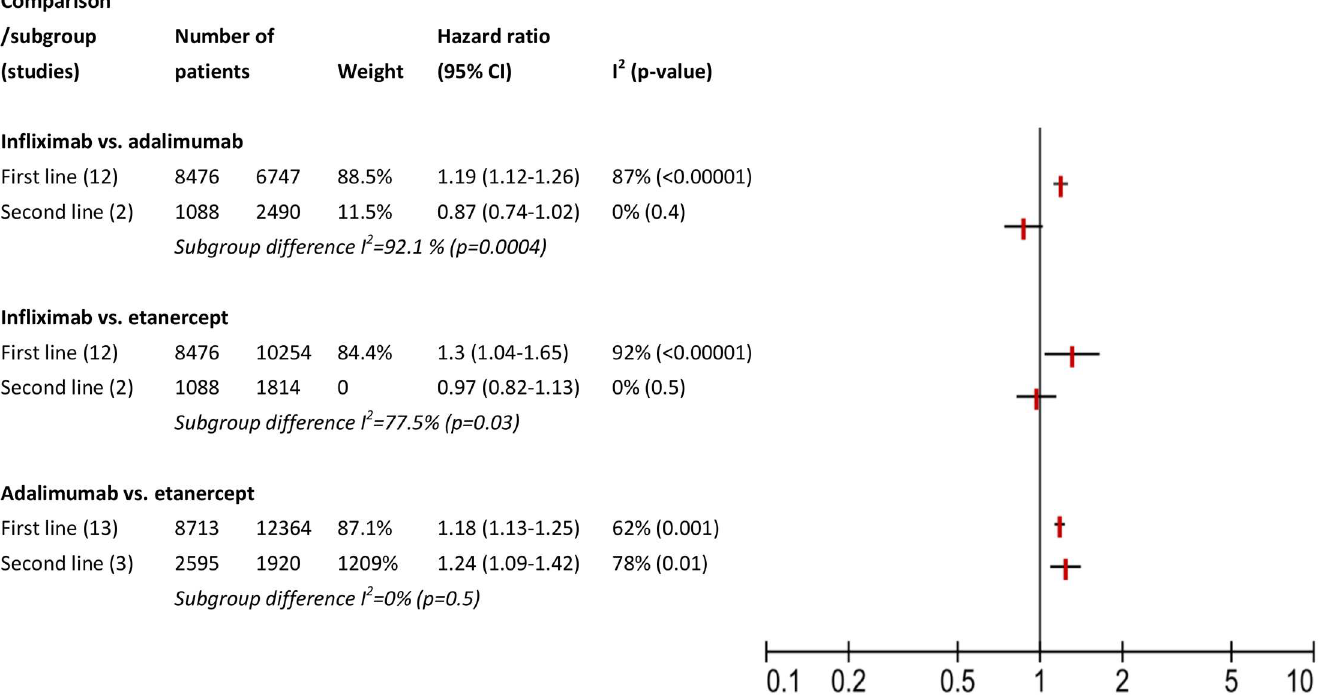
S1 Fig. Forest Plots: Hazard Ratios of included studies: Infliximab vs. Adalimumab. (TIFF) S2 Fig. Forest Plots: Hazard Ratios of included studies: Infliximab vs. Etanercept. (TIFF)